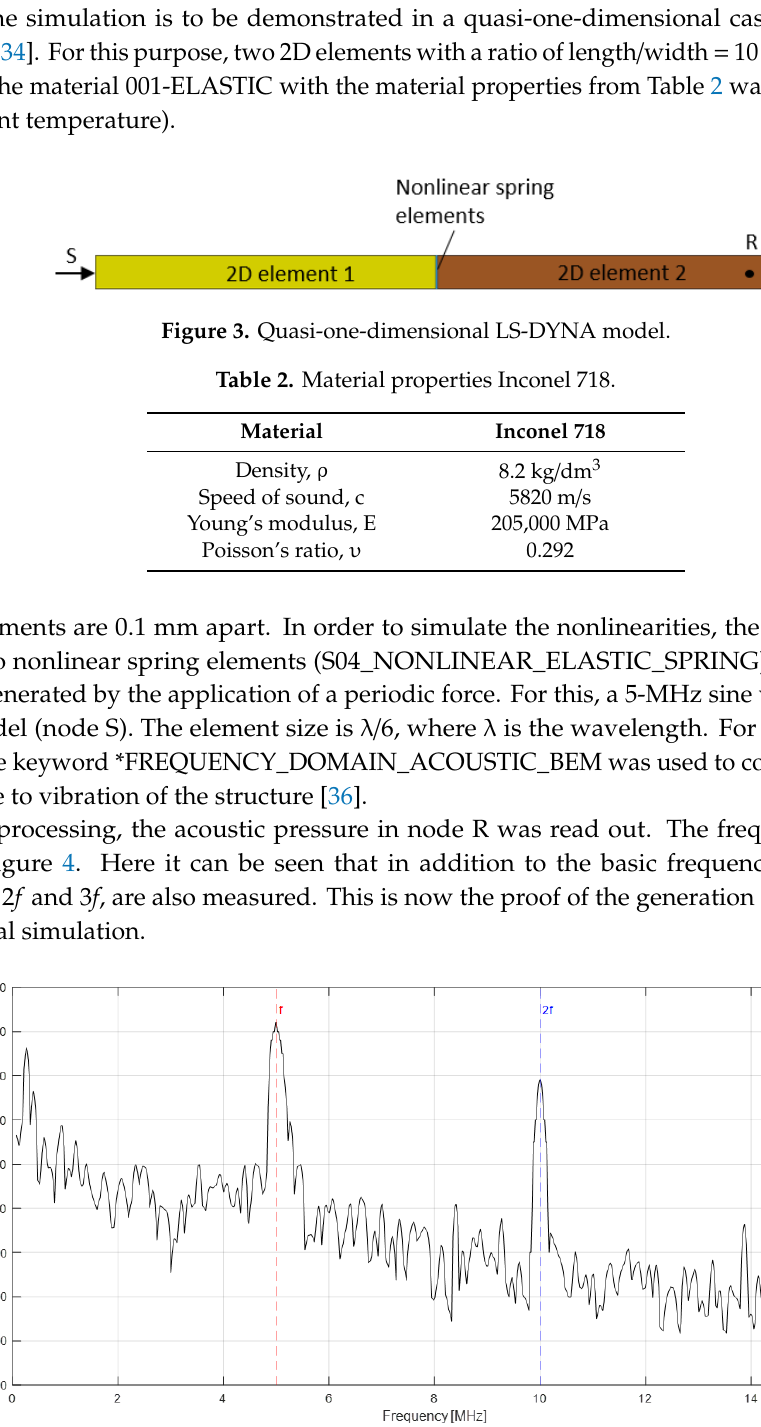
Figure 4. Quasi-one-dimensional frequency spectrum, LS-DYNA simulation with excitation frequency f = 5 MHz.